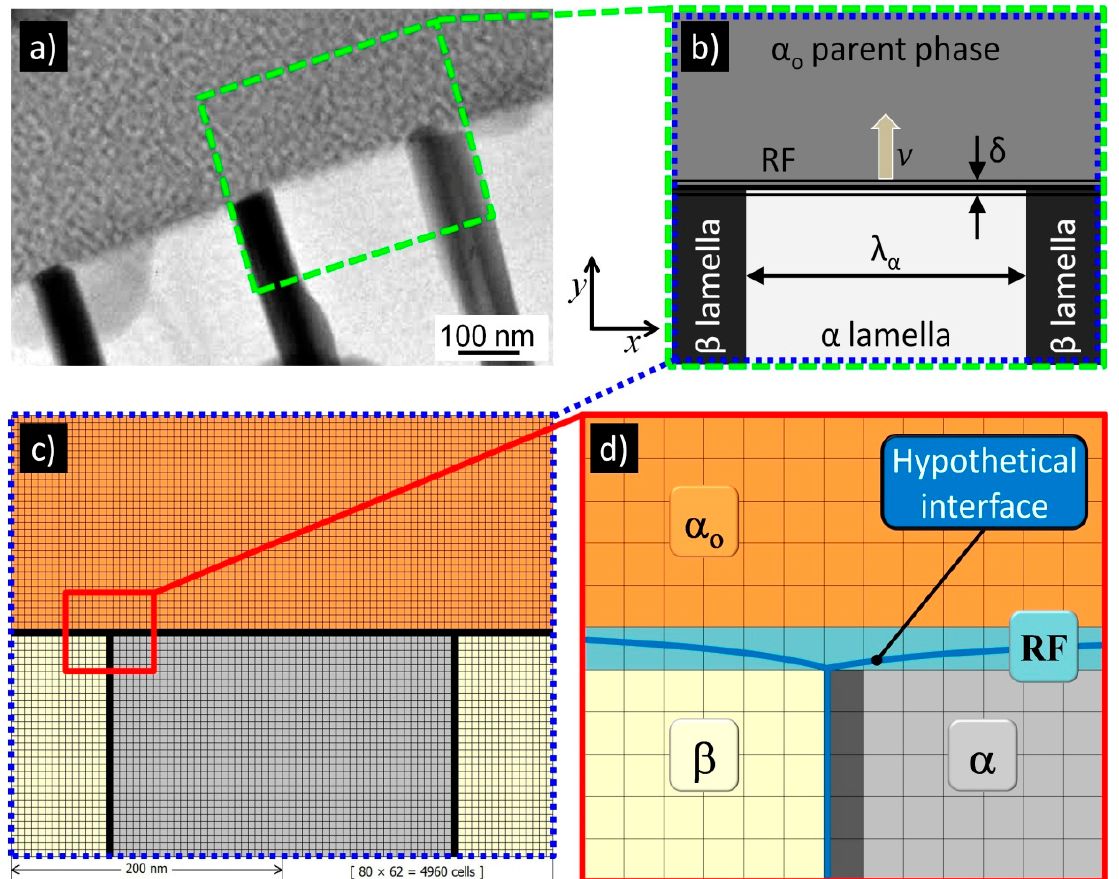
Figure 4. Scheme showing the concept of digital material representation based on digitalisation of the metallographic image ( a ) through the reproduced arrangement of an individual cell for the DP reaction ( b ) and its conversion into the cellular automata grid ( c ). Zoomed fragment of the CA grid ( d ) presents the hypothetical interface (RF) and, in effect, the implicit character of its tracking in the CA model.